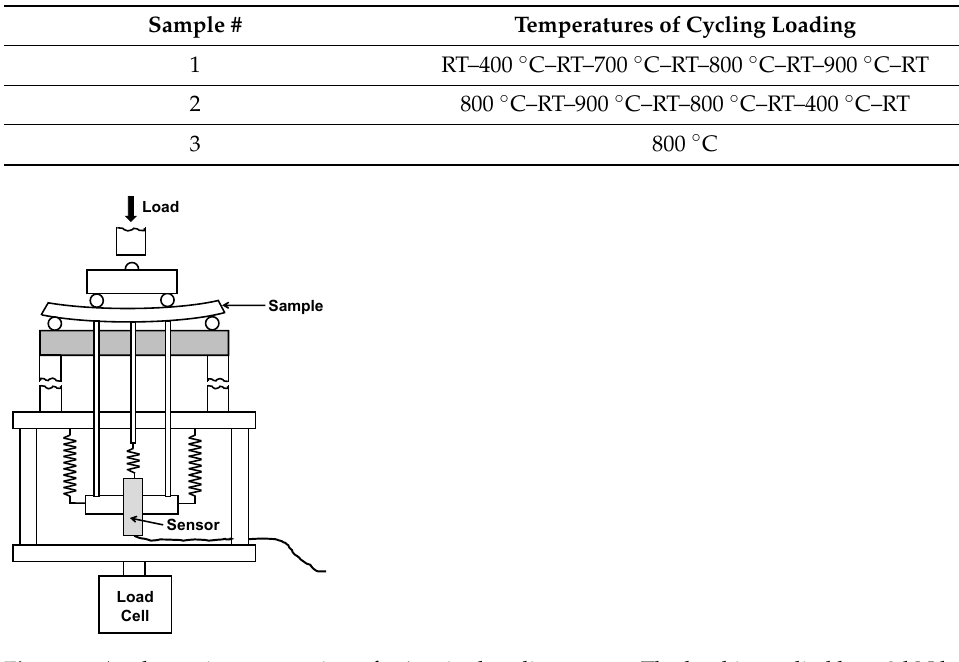
Table 1. Heating histories of three LaCoO 3 samples.